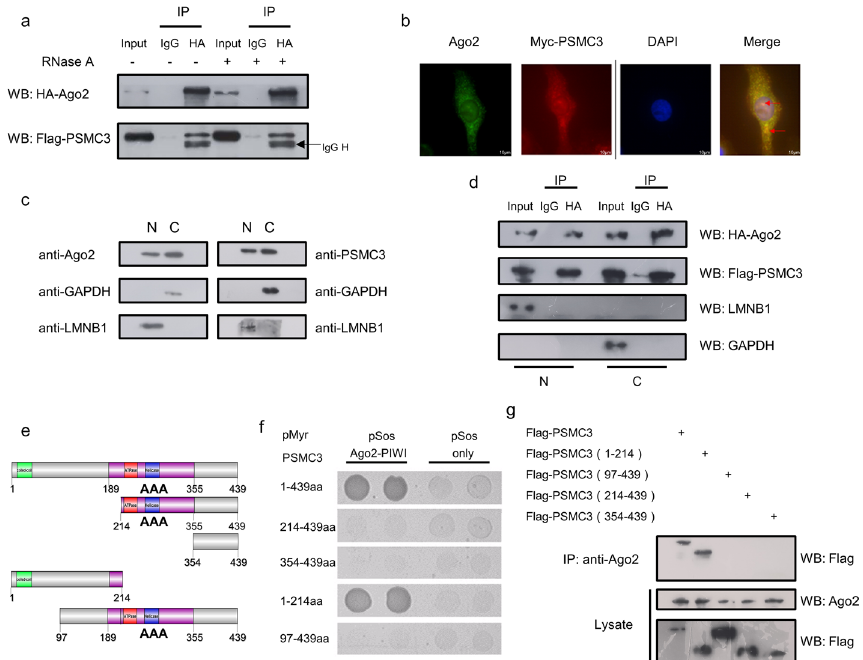
Fig. 2 The coiled-coil region of the N-terminus of PSMC3 interacts with human AGO2. a PSMC3 interacts with AGO2 in an RNA-independent manner. HeLa cells were co-transfected with HA-AGO2-PIWI and Flag-PSMC3. Immunoprecipitation assays were performed with anti-HA antibody and western blotting with anti-Flag and anti-HA antibodies. For lanes 4, 5, and 6, cell lysates were incubated at room temperature with RNase A (10 mg/ml) for 30 min. b PSMC3 colocalizes with AGO2 in HeLa cells. Myc-PSMC3 was transfected into HeLa cells. Forty-eight hours after transfection, immunofluorescence assays were performed with the indicated antibodies, then imaged by confocal microscopy. Scale bar, 10 µm. c Western blotting assays were used to detect AGO2 and PSMC3 protein levels in nucleoplasm or cytoplasm from HeLa cells. d PSMC3 interacts with AGO2 in both nucleoplasm and cytoplasm. HeLa cells were co-transfected with HA-AGO2 -PIWI and Flag-PSMC3. Then nucleoplasmic or cytoplasmic extracts were harvested and analyzed by western blotting assays. e Schematic representation of the full-length and truncated PSMC3s used to map AGO2-binding sites. PSMC3 possesses an N-terminal domain and an AAA ATPase domain that contains an ATP-binding motif (black box) and a helicase motif (white box). f A yeast two-hybrid